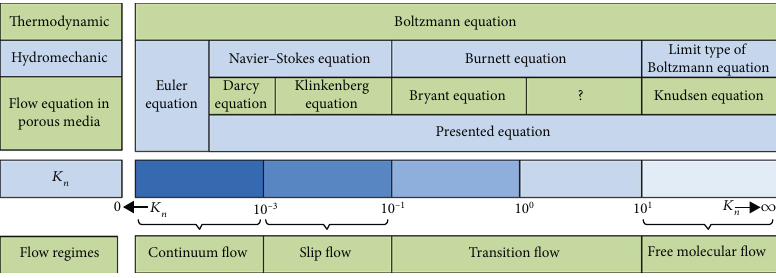
Figure 2: Illustration of fl ow regimes and corresponding equations